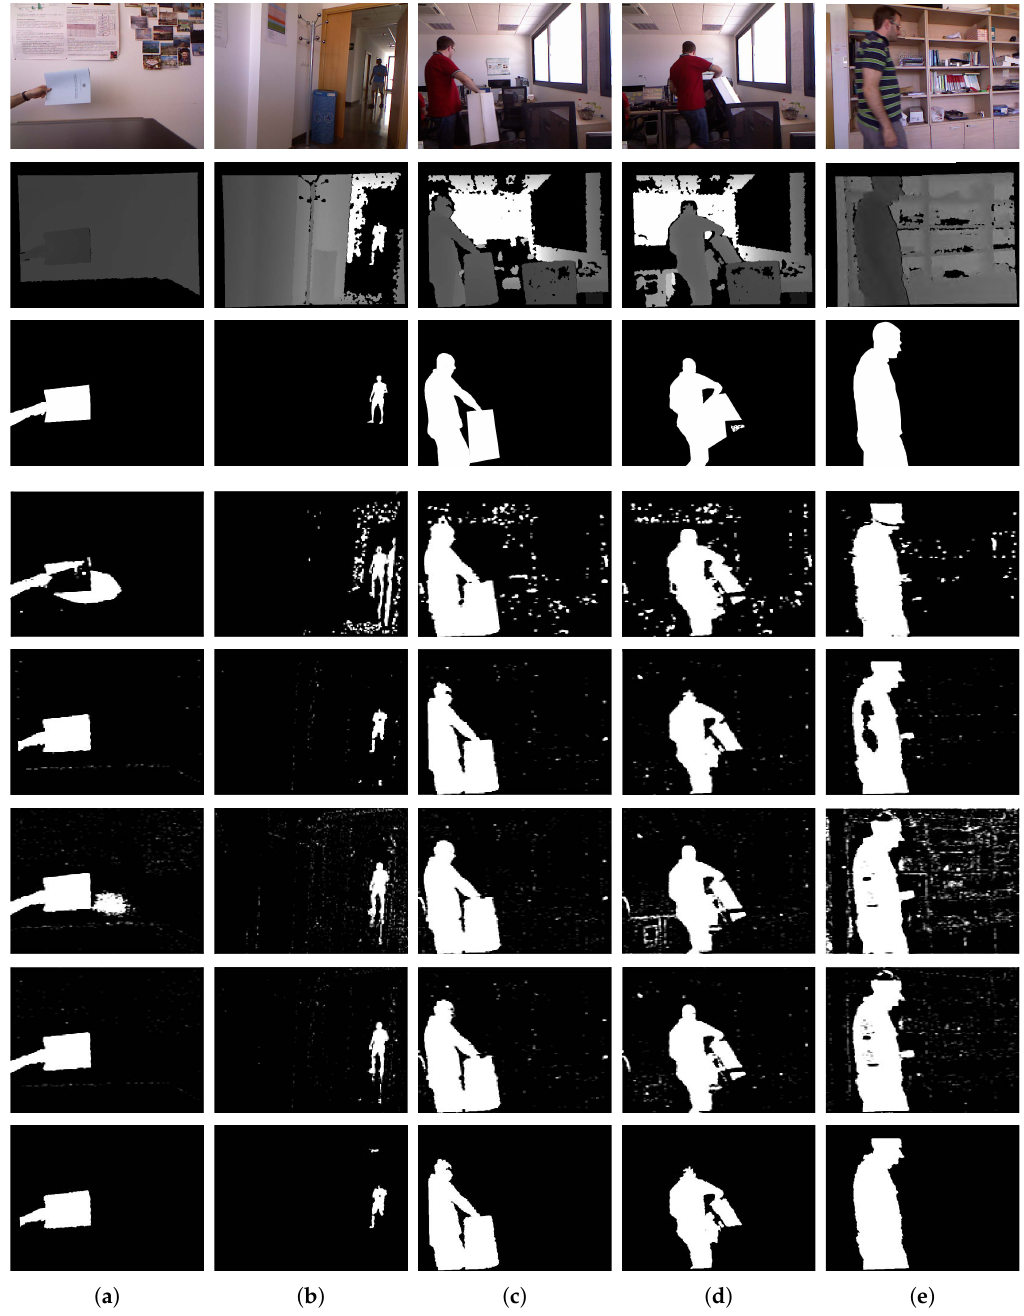
Figure 10. Experimental results using Fernandez’s Kinect dataset (( a – e ) indicate Wall #93; Hallway #120; Chair Box #278, #286; Shelves #197, respectively). Rows 1–3 are the color images, depth images, and ground truth, respectively. Rows 4–8 present the results given by MOG4D, CB1D, CB4D, DECB, and the proposed method,